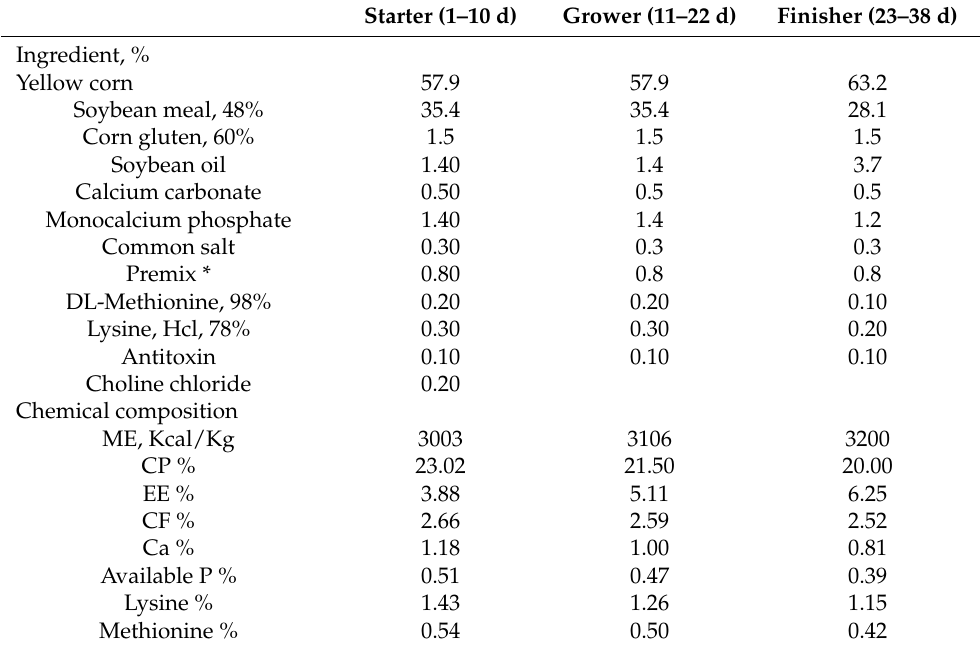
Table 1. Ingredients and chemical composition of the basal